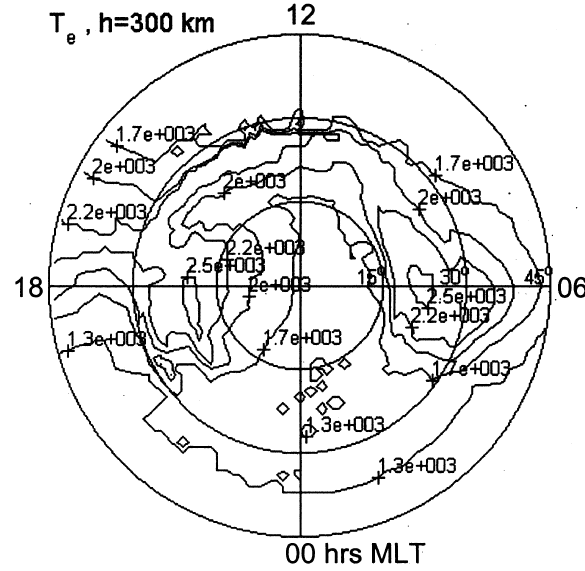
Fig. 9. Simulated pattern of the ion temperature (in K) at h = 300 km.